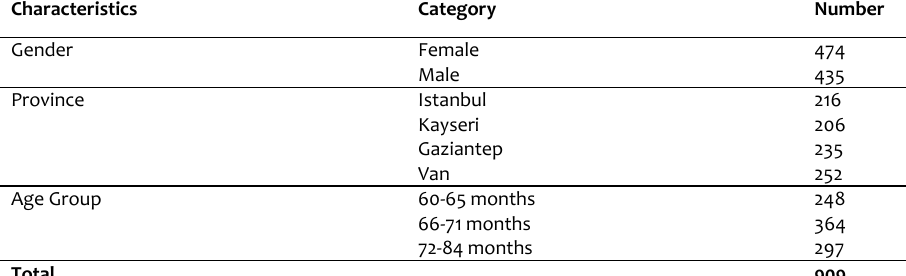
Table 1. Personal Characteristics of the Students in the Sample